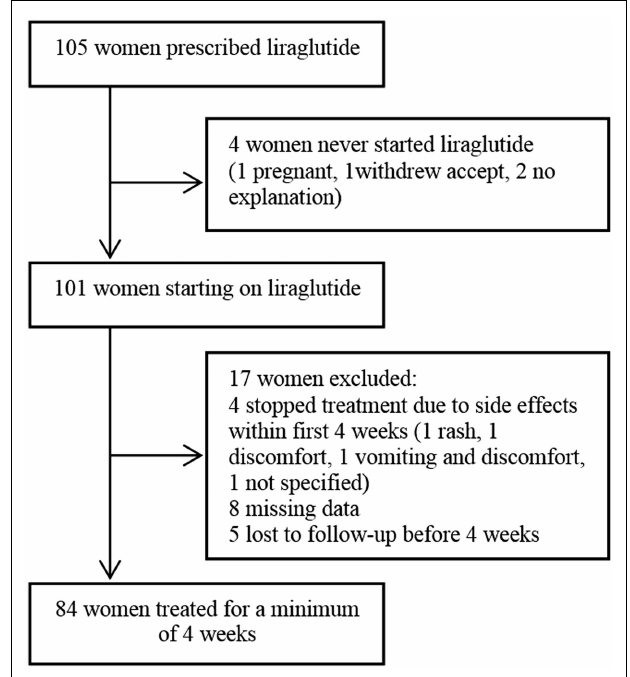
FIGURE 1 | Overview of women included in the study